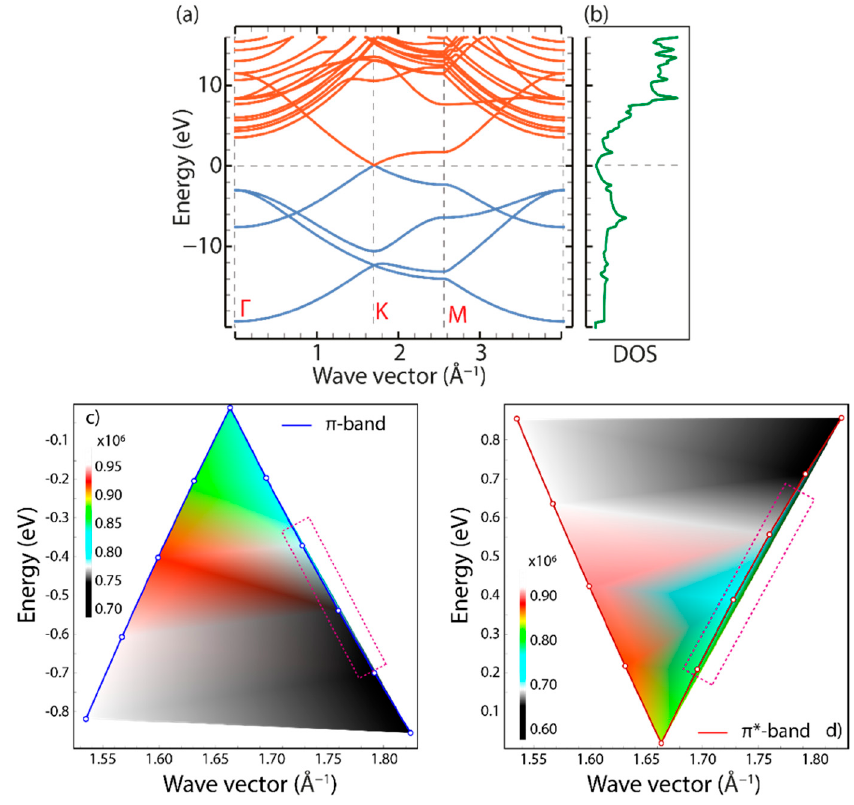
Figure 2. ( a ) Band structure and density of states (DOS) of graphene computed by density functional theory (DFT). Color density plots ( b , c ) for the π and π * bands in the vicinity of K point vs. the charge carrier velocity, respectively. Adapted from Ref. [31].